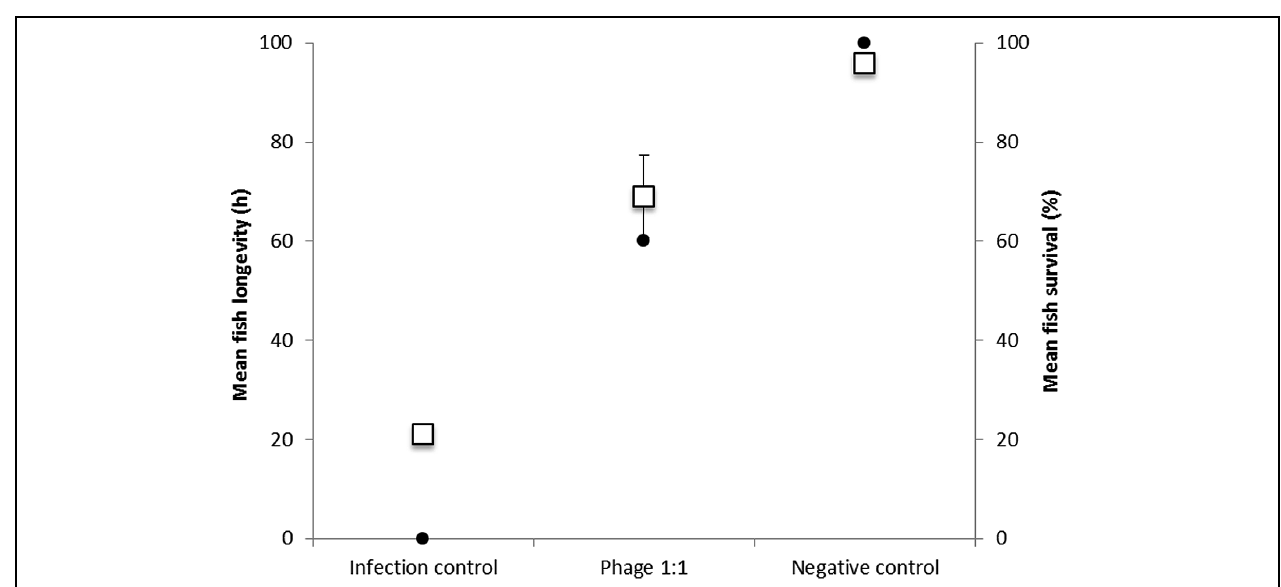
Table 2 for statistical